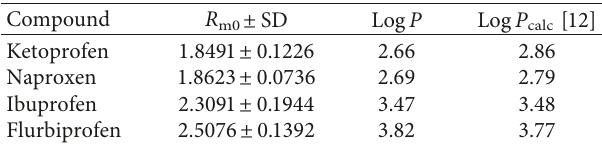
Table 3: The R m0 , Log P , and Log P calc values of the investigated compounds.